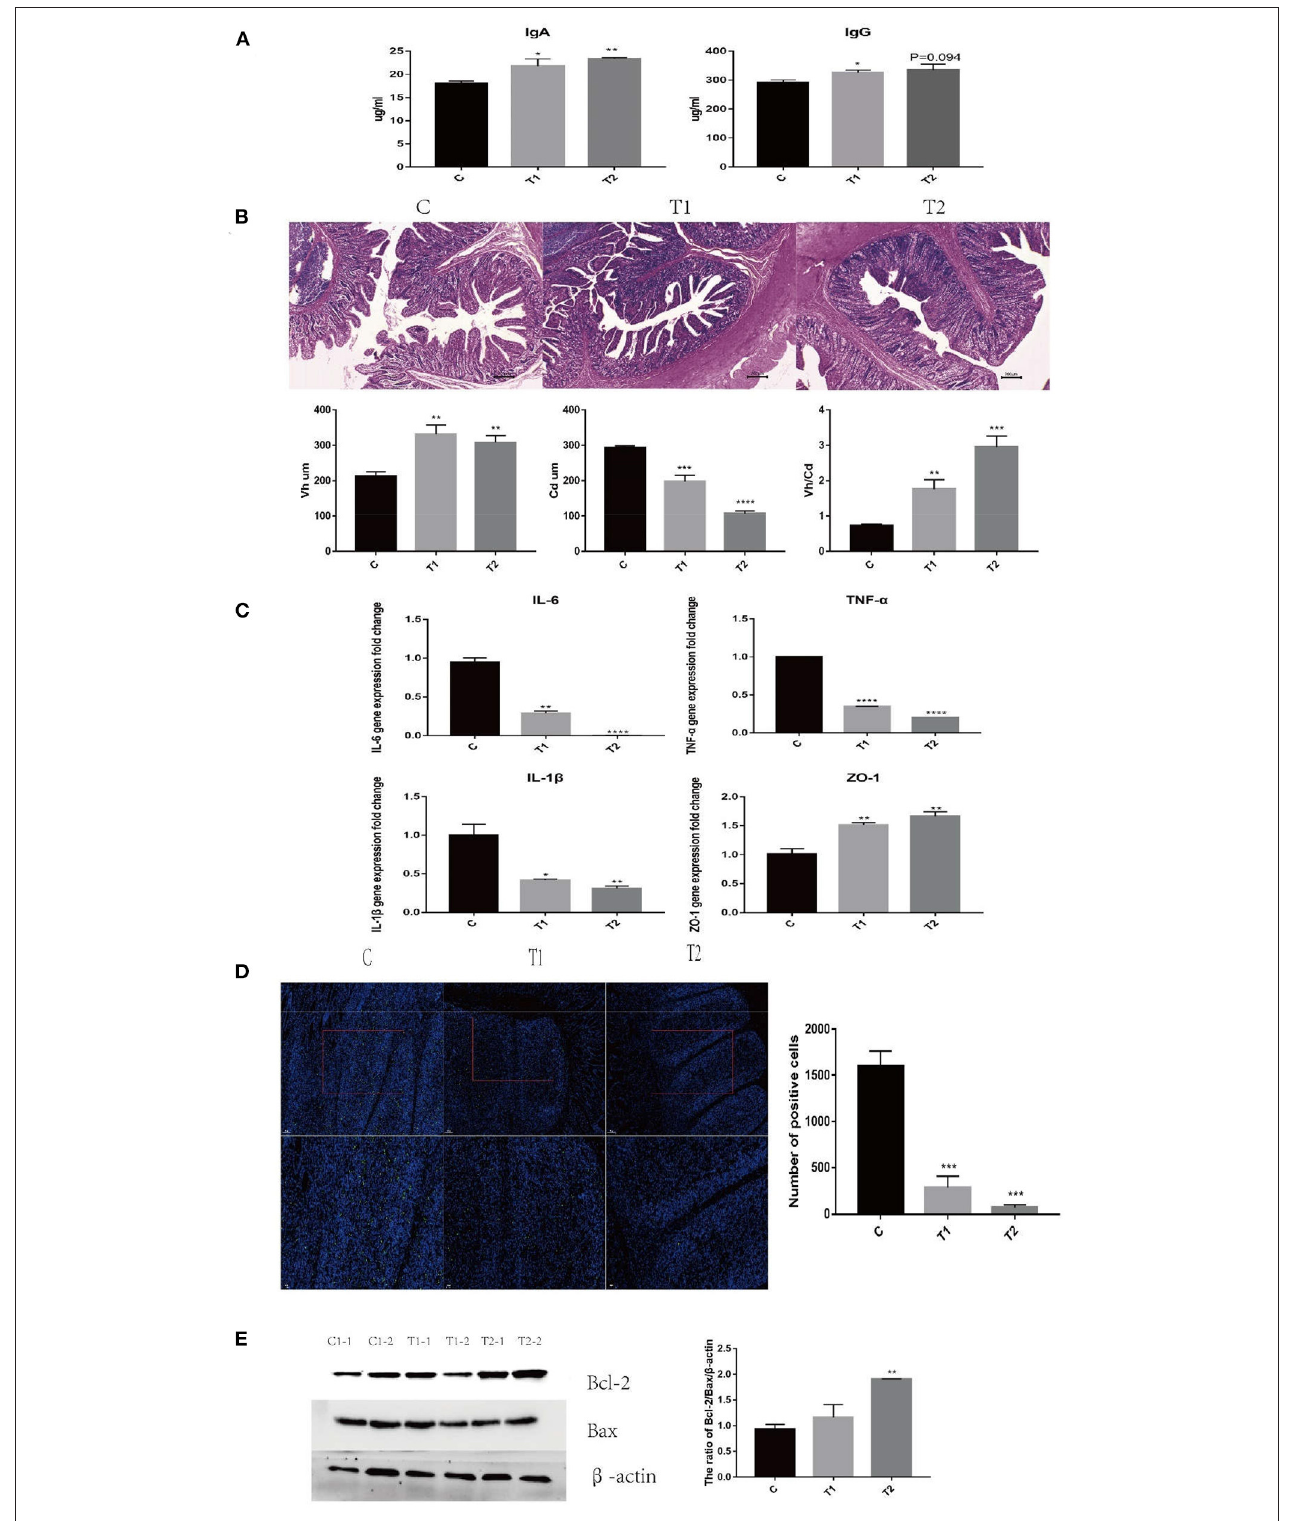
FIGURE 1 | Hermetia illucens larval feed improves the immune performance of piglets and repairs the intestinal barrier damage caused by ETEC K88 infection. (A) IgA and IgG secreted in piglet serum were measured by ELISA ( n = 4). (B) The ratio of Vh/Cd (villus height/crypt depth) of piglet ileum was immunohistochemically analyzed. (C) The mRNA expression of TNF- α , IL-6, Zo-1, and IL-1 β was assessed by RT-PCR. (D) TUNEL staining analysis of ileum cell apoptosis in piglets. (E) Effects of H. illucens larval feed on ileum anti-apoptotic ratio ( n = 4, means ± SEM, ANOVA, * P < 0.05, ** P < 0.01, *** P < 0.001, **** P < 0.0001).